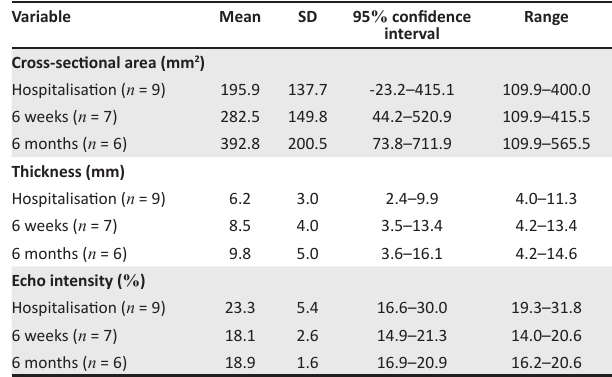
TABLE 2: Results for rectus femoris and vastus lateralis muscles with respect to muscle cross-sectional area, thickness and echo intensity using diagnostic ultrasound imaging.